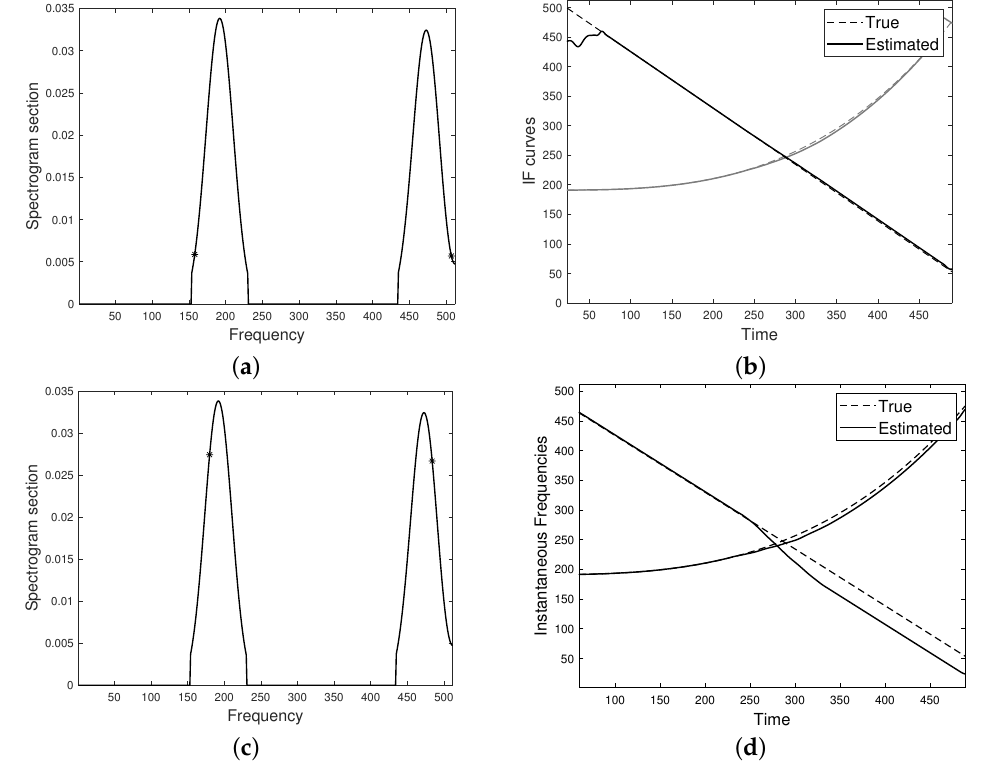
Figure 6. ( a ) Section of the spectrogram in Figure 5a. The star markers indicate spectrogram values at the frequency points ξ 1 , ξ 2 , close to the external bandwidth boundary, employed for defining the linear system, as in Equation (11), whose solution leads to IFs estimation ( b ). ( c ) The frequency points ξ 1 , ξ 2 are selected close to spectrogram maxima, giving the estimated IFs ( d ).